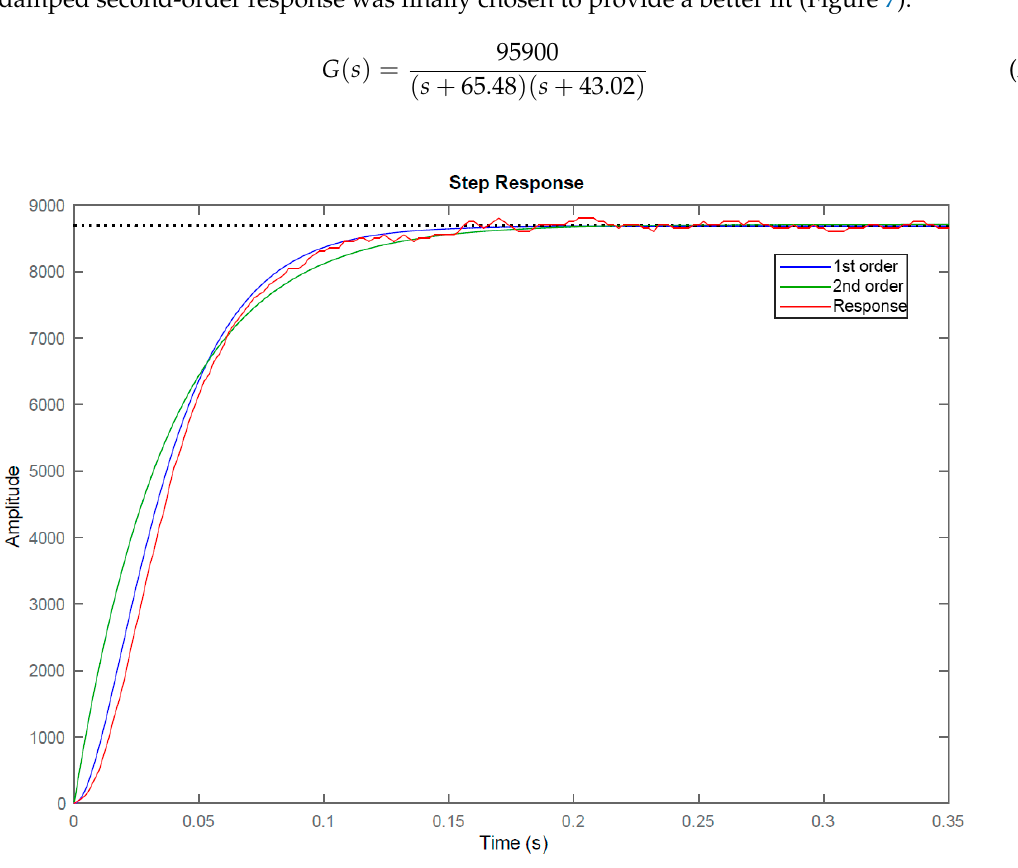
Figure 7. Step response for the motor identification fits to a first or underdamped second-order